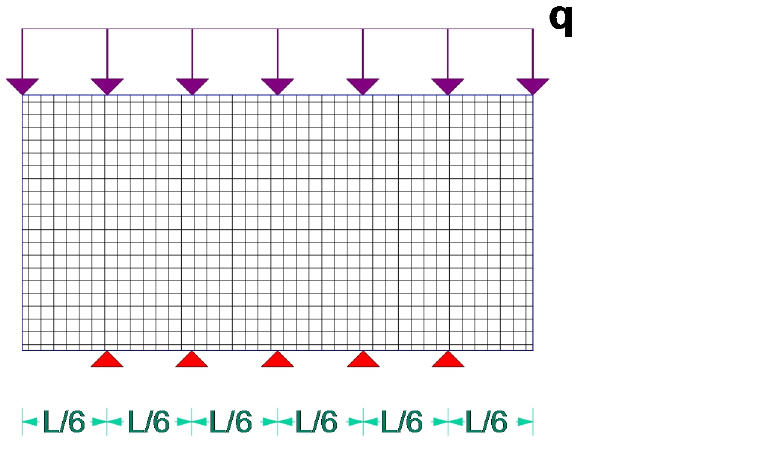
Figure 9. Definition of test example C.